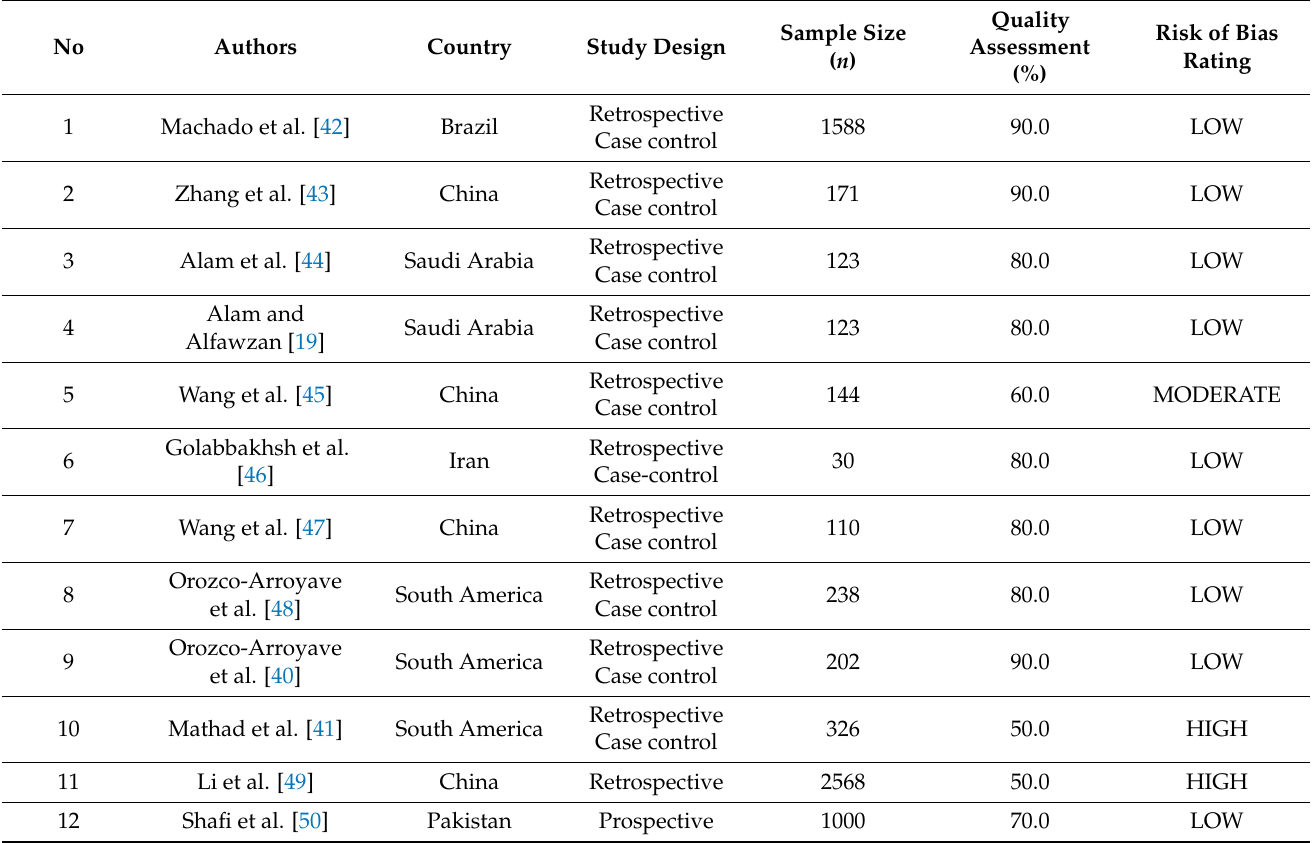
Table 5. The summary results of Risk of bias assessment as per JBI critical appraisal